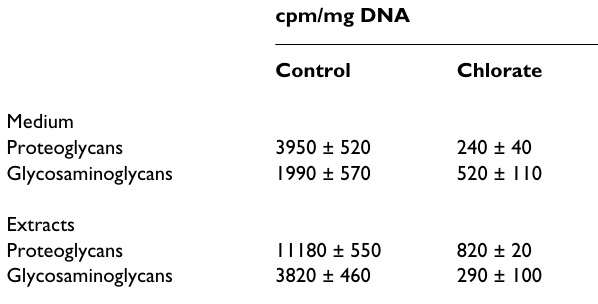
Table 1: Effect of Chlorate on [ 35 S]-SO 4 Incorporation into Proteoglycans and Glycosaminoglycans in C2C12